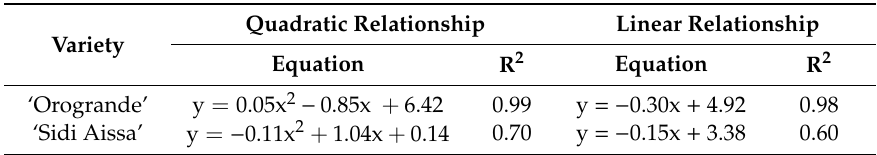
Table 6. Regression analyses of the relationship between WUE ( y ; kg m − 3 ) and amount of water